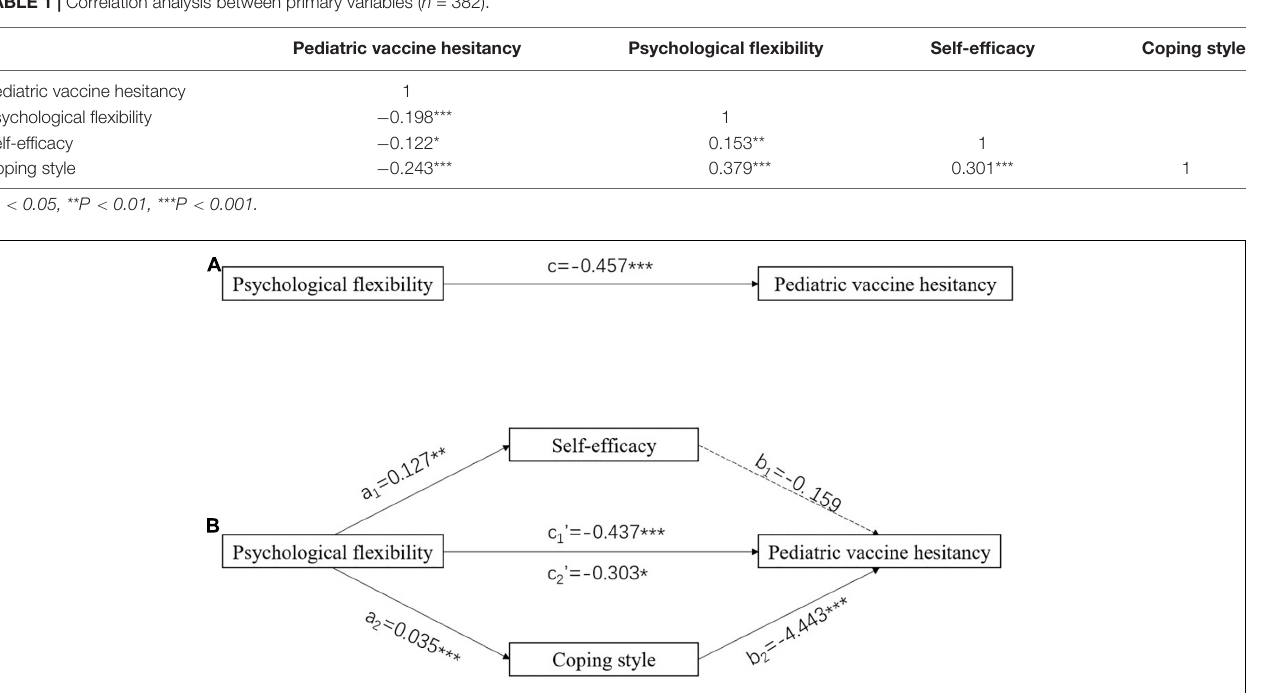
FIGURE 1 | Parallel mediation model. (A) Total effect model. (B) Models with self-efficacy and coping style as mediators, respectively. Numbers associated with a, b, c, and c (cid:48) are unstandardized regression coefficients. * P < 0.05, ** P < 0.01, *** P < 0.001.